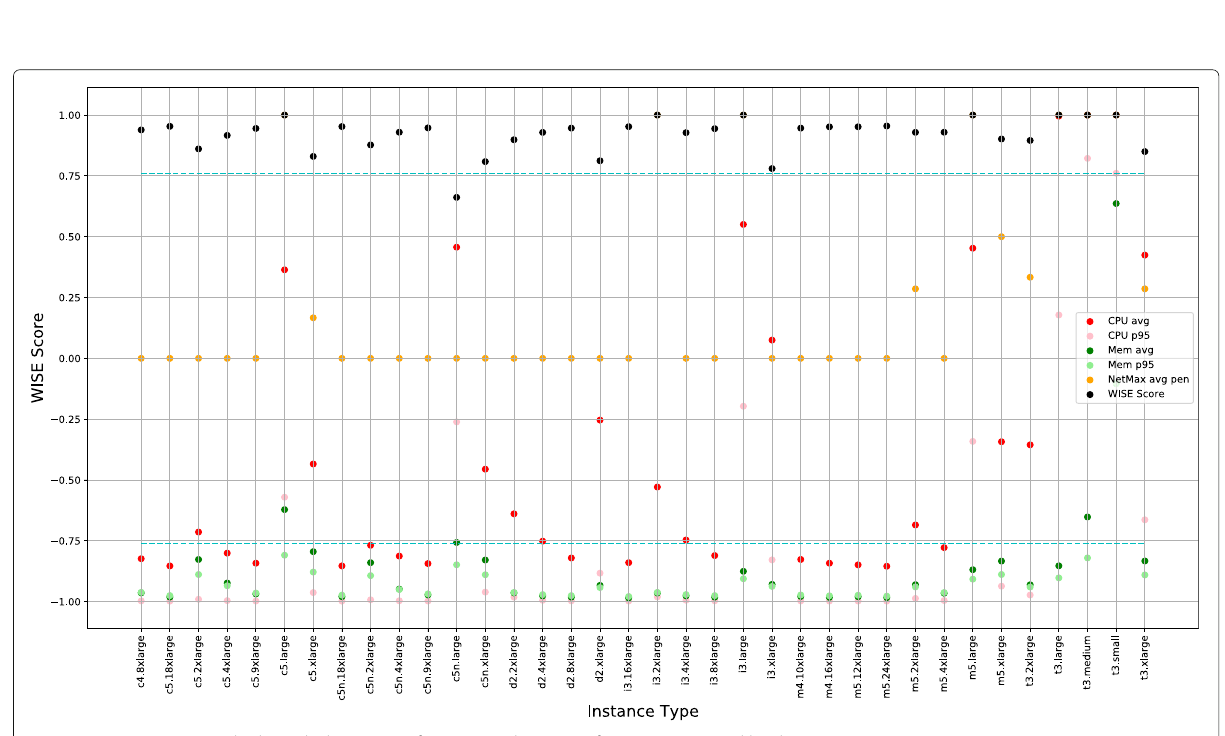
Fig. 9 WISE scores using the hyperbolic tangent function and (cid:4) 2 -norm for Streaming